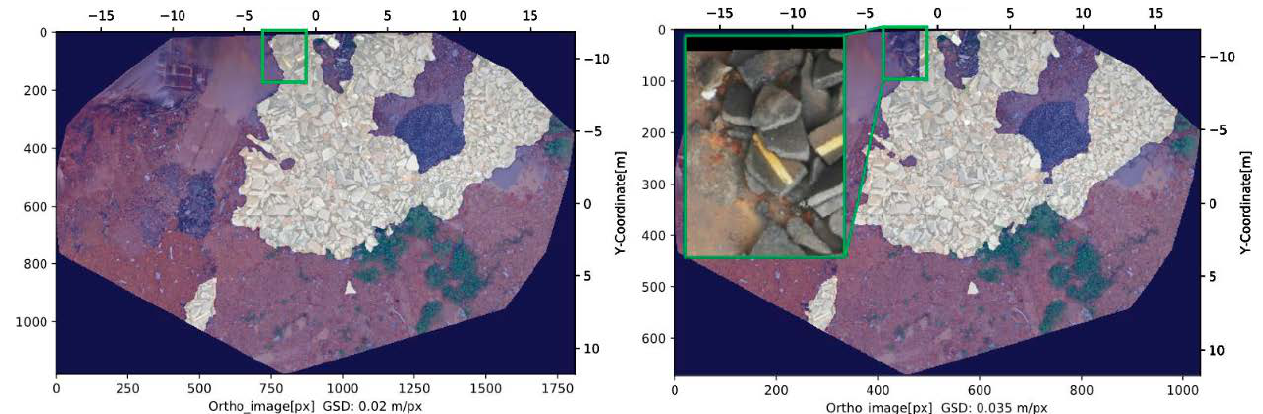
Figure 3. Semantic segmentation of regions that contain demolition debris